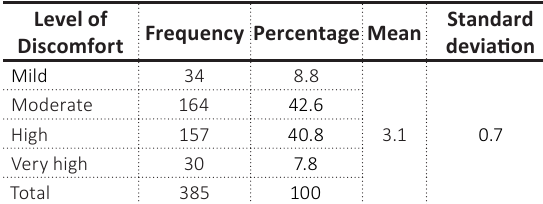
Table 3. Incidence of emotional discomfort